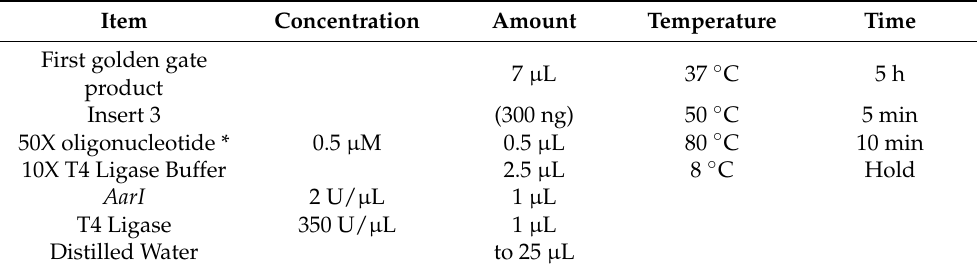
Table 6. Golden Gate reaction components and thermal conditions.